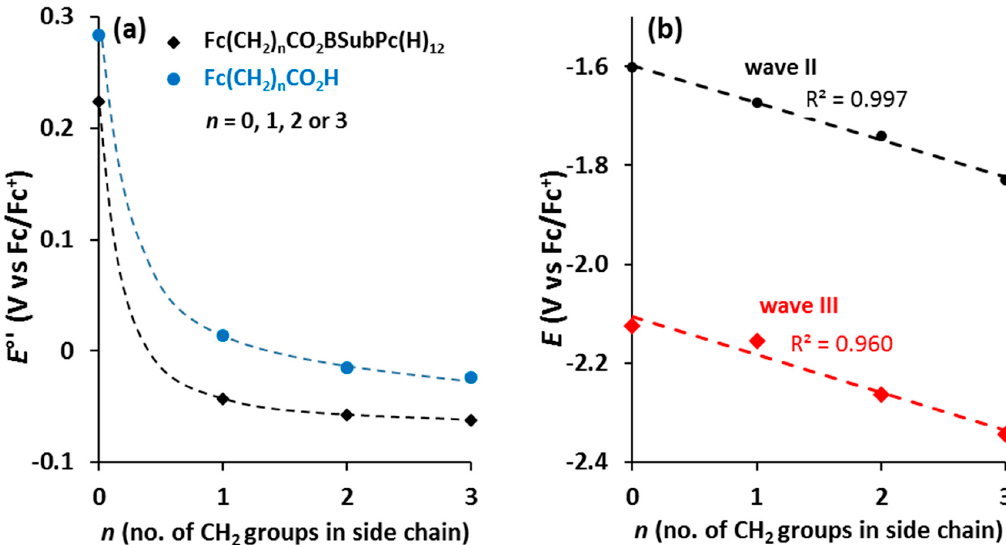
Figure 4. ( a ) Relationship between E ◦ ’ of the Fe group and the number n of CH 2 groups in the side chain of Fc–(CH 2 ) n –CO 2 for ferrocenyl carboxylic acids 1 – 4 and ferrocenylsubphthalocyanine dyads 7 – 10 . Data of 1 – 4 from reference [14], data of 9 from reference [24]. ( b ) Relationship between E ◦ ’(wave II) and E pc (wave III) and n , of the first and second ring-based reductions respectively, of ferrocenylsubphthalocyanine dyads 7 – 10 .